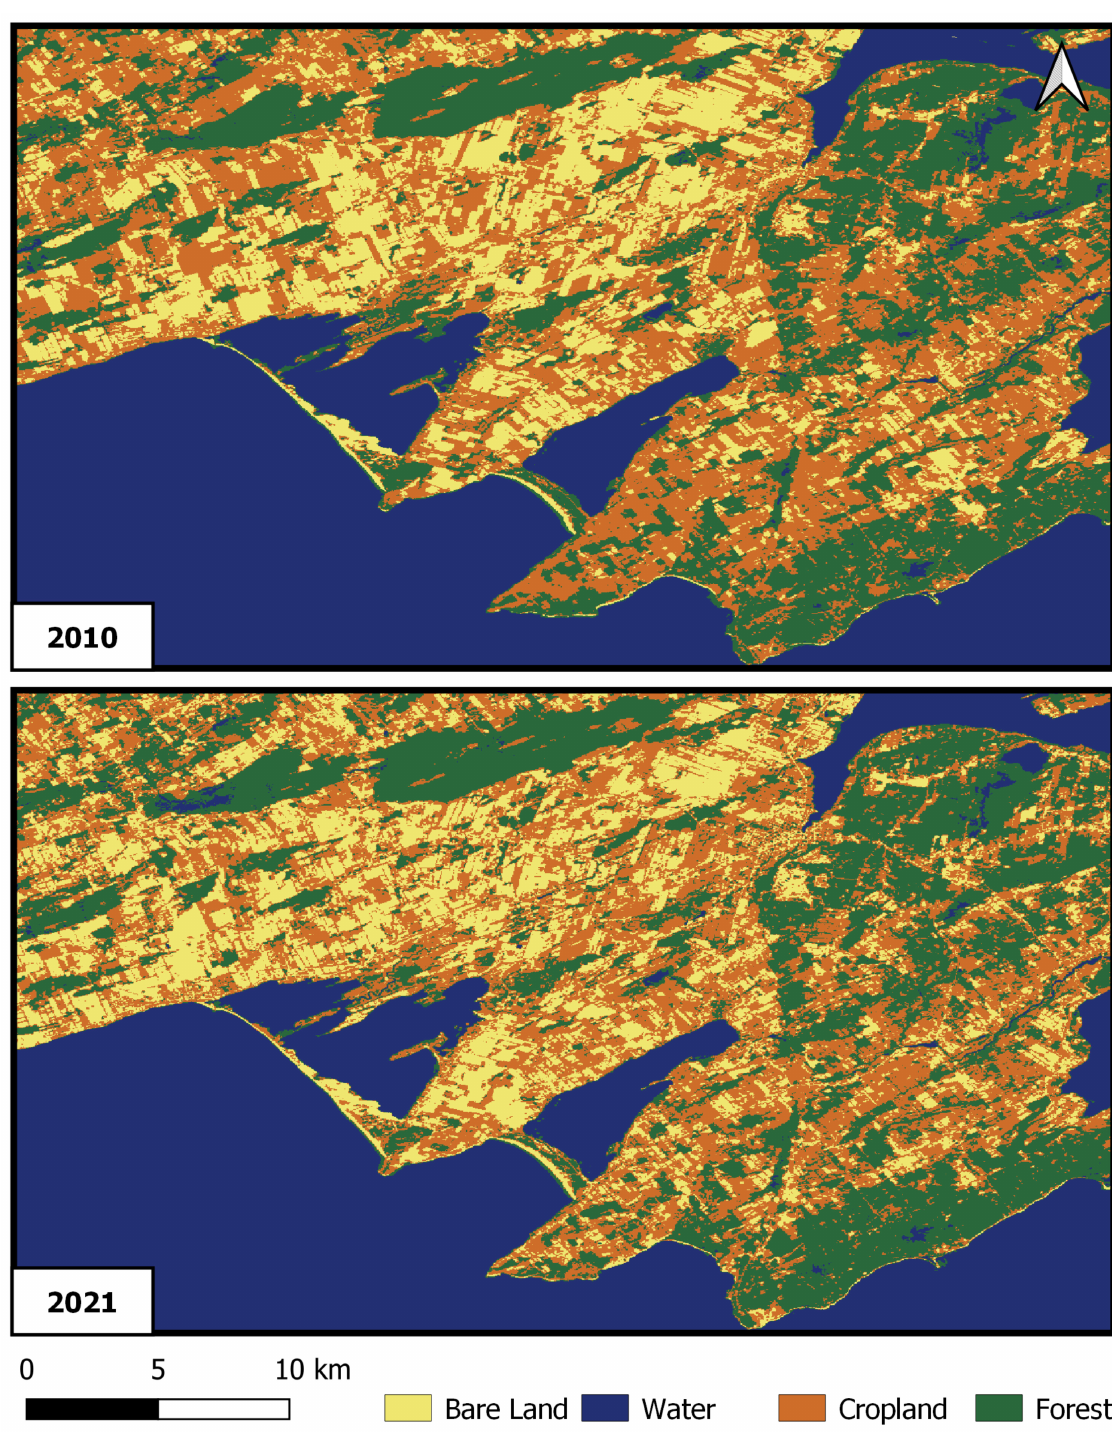
Figure 15. The study area’s LULC map in 2010 and